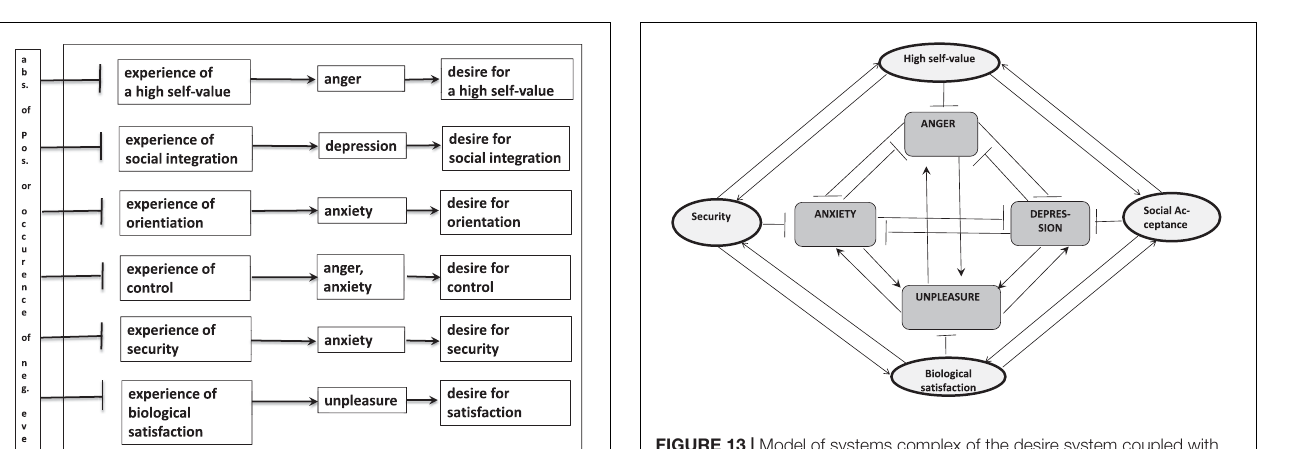
FIGURE 13 | Model of systems complex of the desire system coupled with the emotion system. Bear in mind: the component “pleasure” of Figure 11 is substituted here by the opposing system “unpleasure”.